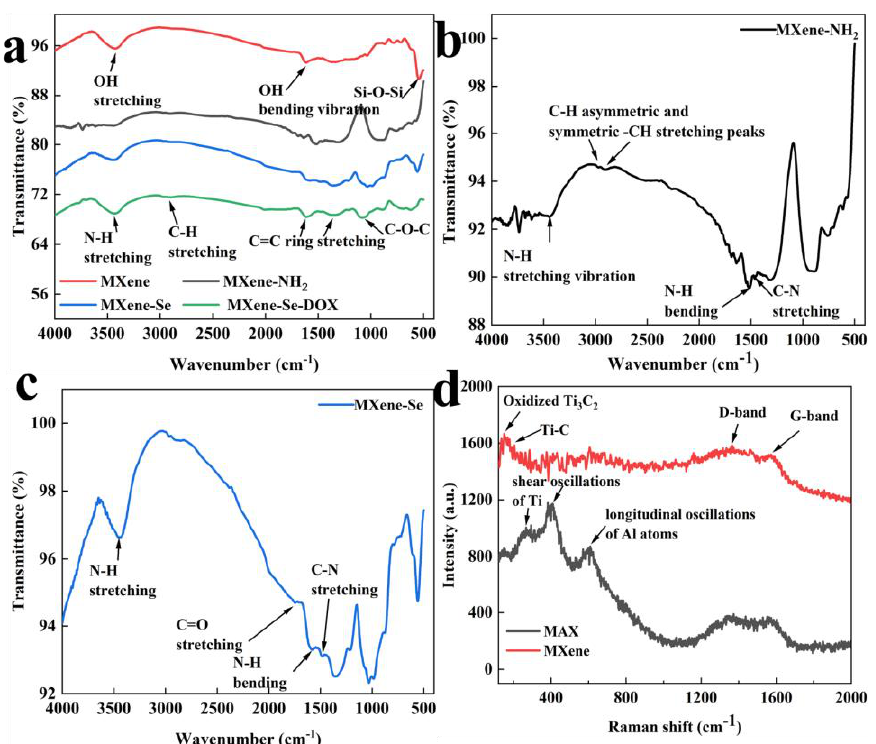
Figure 1. ( a ) FTIR spectra of MXene, MXene-NH 2 , MXene-Se, and MXene-Se-DOX. ( b ) Magnified FTIR spectrum of MXene-NH 2 . ( c ) Magnified FTIR spectrum of MXene-Se. ( d ) Raman spectra of Ti 3 AlC 2 (MAX) and MXene nanosheets.